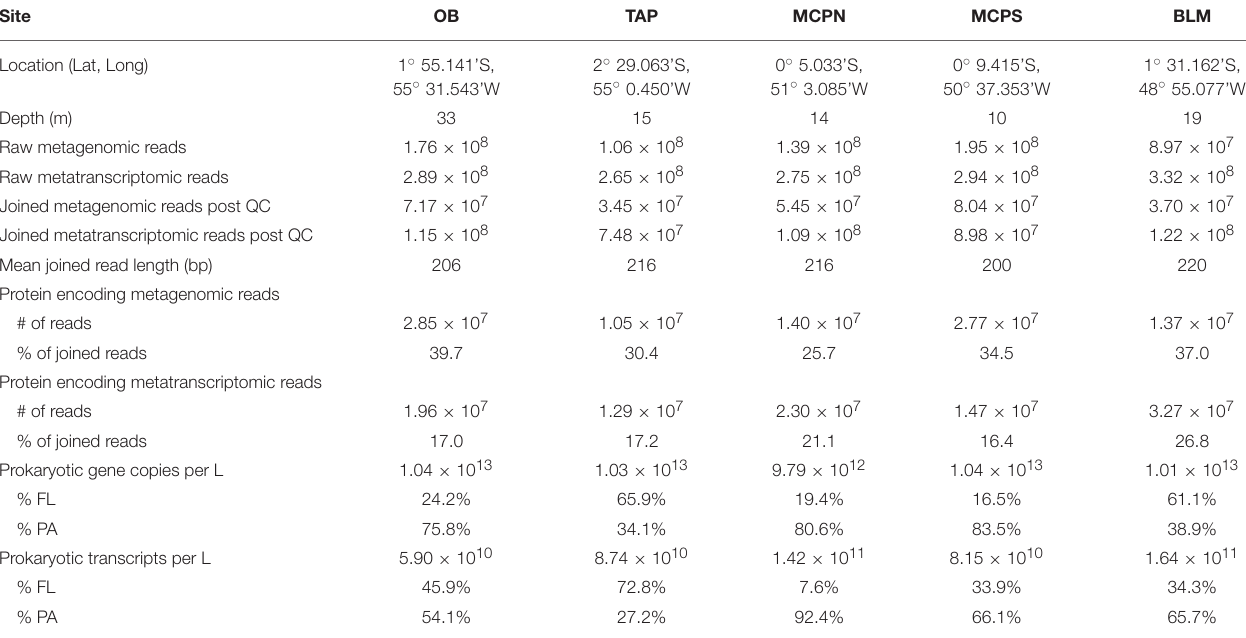
TABLE 1 | Metagenome and metatranscriptome data summaries for five Amazon River stations in May 2011 sampled at 50% depth (10–33 m).